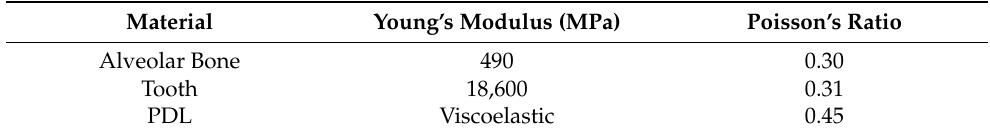
Table 1. Material properties. Material Young’s Modulus (MPa) Poisson’s Ratio Alveolar Bone